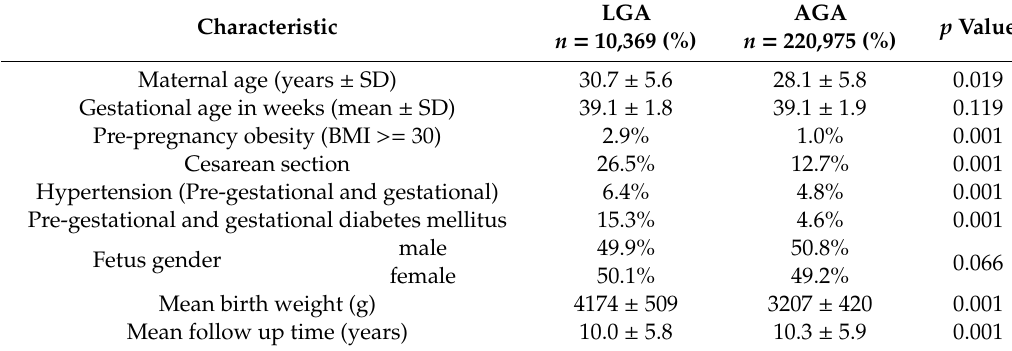
Table 1. Maternal demographics and pregnancy characteristics at index pregnancy divided into patients with and without a history of large for gestational age